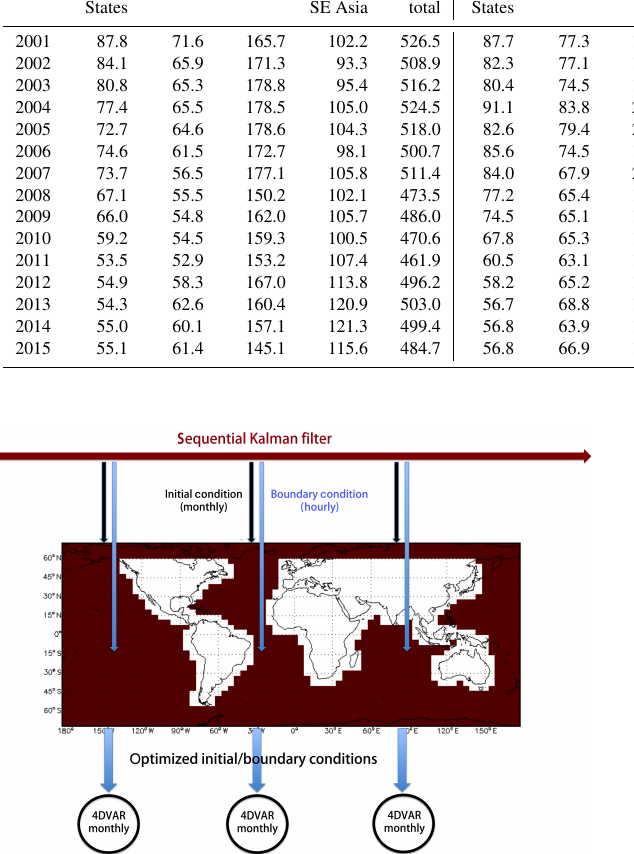
Figure 3. Schematic diagram for methodology of the assimila- tion system. Sequential Kalman filter was run from 1 March 2000 to 31 December 2015 to produce the optimized initial conditions (monthly) and boundary conditions (hourly). Monthly 4D-Var in- versions were performed with the optimized initial conditions. Only MOPITT data over land (white grids) were assimilated in the 4D- Var inversions, while the CO abundances over ocean (red grids) were defined as boundaries and rewritten using the optimized hourly CO fields from the Kalman filter. The Kalman filter run is com- pletely independent of the 4D-Var inversions. There is no feedback of the 4D-Var inversion results to the boundary